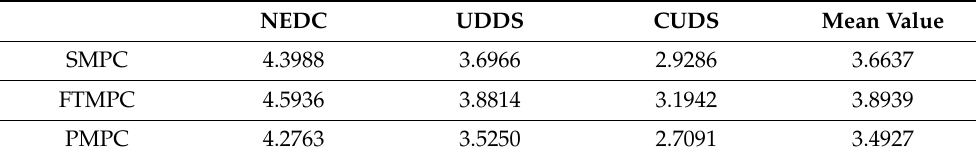
Table 5. Comparison of fuel economy